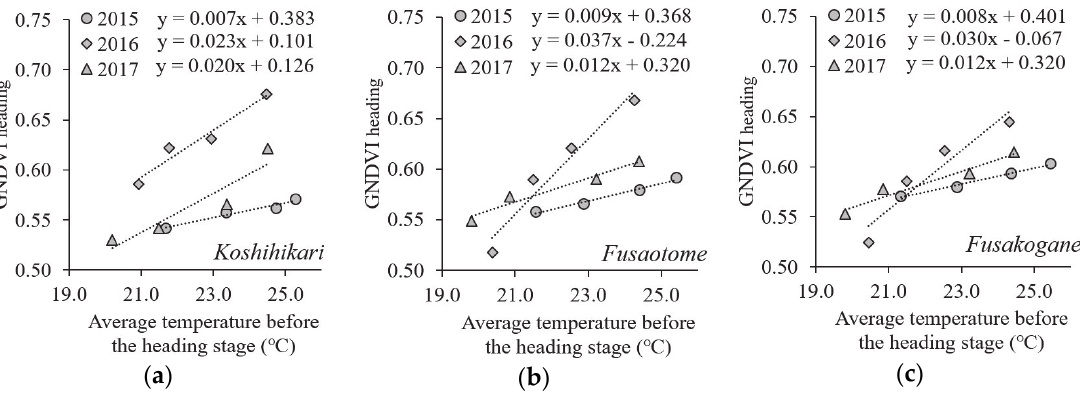
Figure 6. Correlation between average temperature from the transplantation date to the heading stage ( ˚ C) and green normalized difference vegetation index (GNDVI) at the heading stage : ( a ) shows the results of Koshihikari ; ( b ) shows the results of Fusaotome ; and ( c ) shows the results of Fusakogane. Circles show the samples in 2015, diamonds show the sample in 2016, and triangles show the sample in 2017.